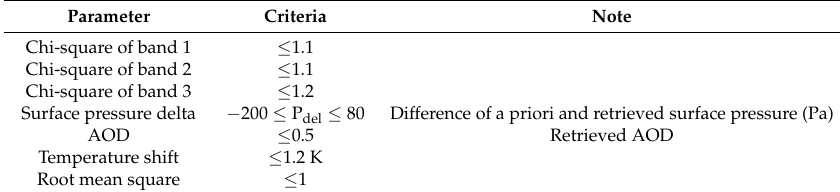
Table 4. Post-screening